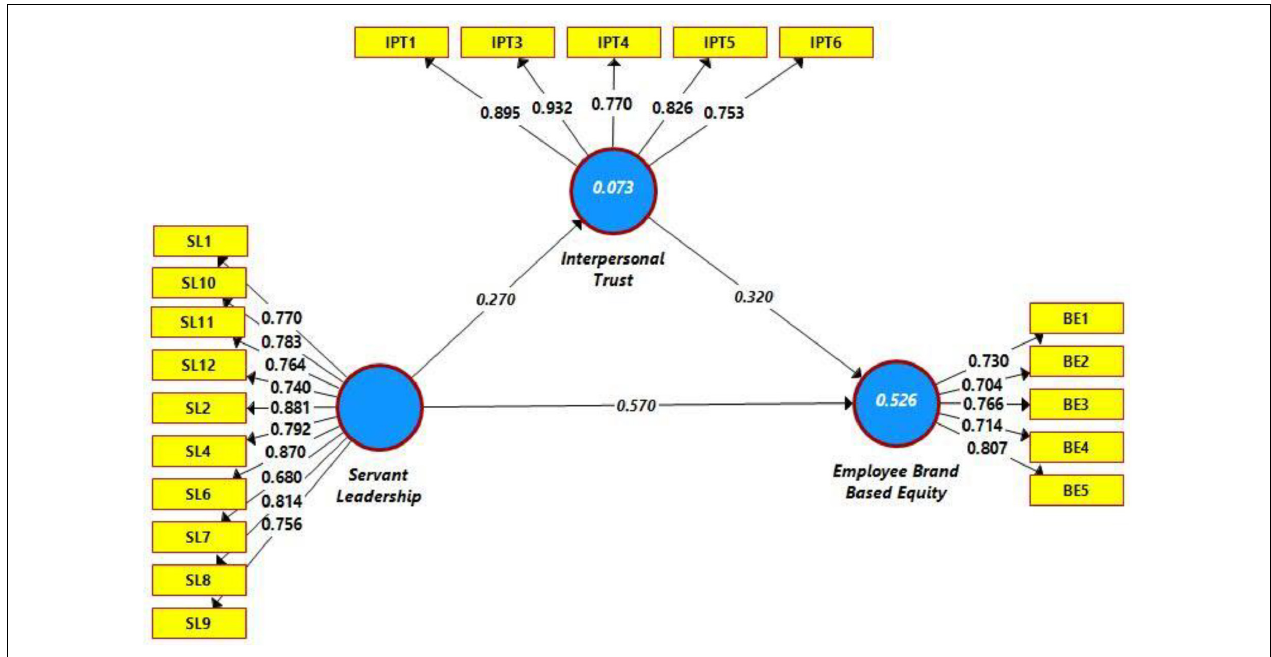
FIGURE 2 | Path estimates.